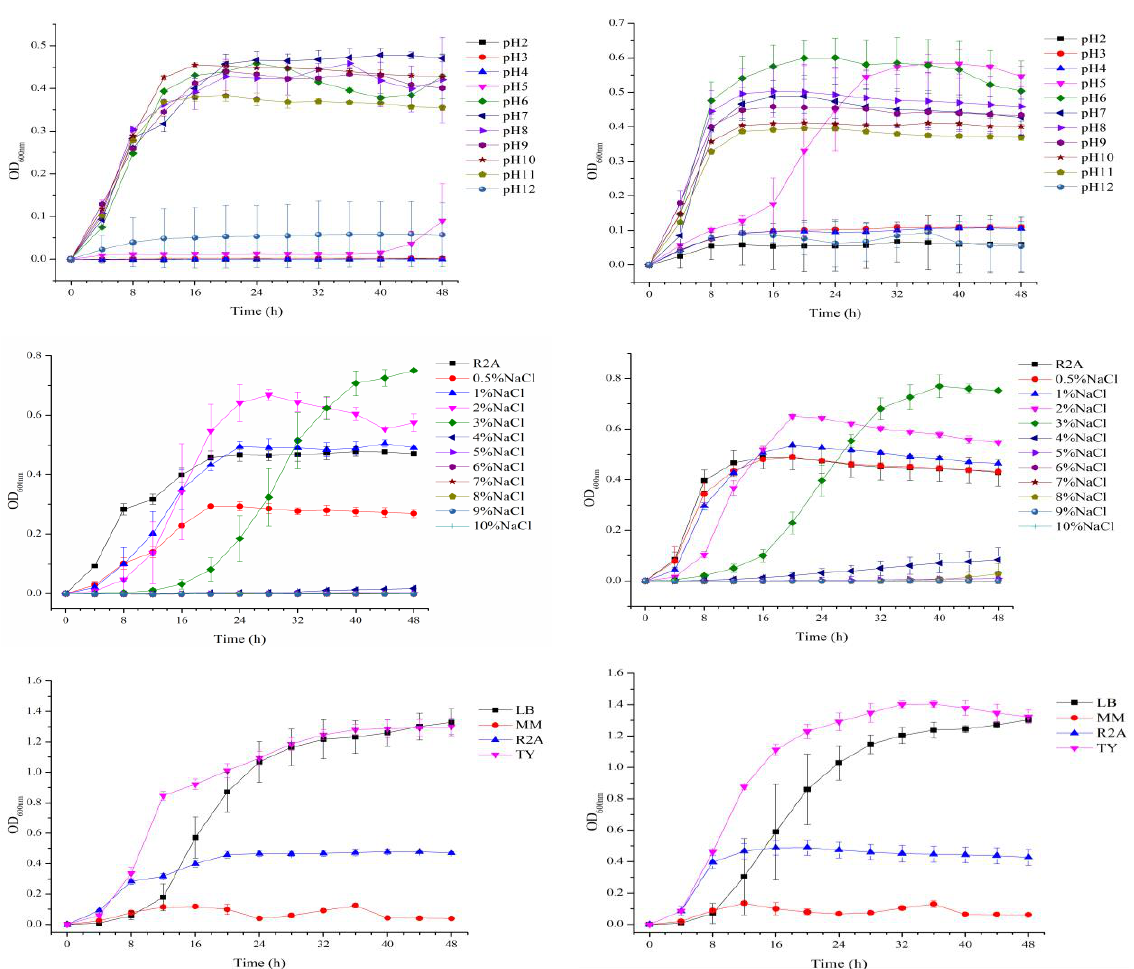
Figure 1. Optimized growth patterns of B. nasdae strains Au-Bre29 and Au-Bre30. Au-Bre29 and Au-Bre30 were cultured individually in R2A medium with different pH levels (2–12, additional NaCl = 0%), different additional NaCl concentrations (0–10%, pH = 7.0), and different media (MM, R2A, TY and LB, pH = 7.0). Performed in the Bioscreen C microbiology reader at 28 ◦ C for 48 h, and the optical densities at 600nm (OD 600nm ) were automatically measured at 4 h intervals. The growth curves display the results of three replicates, and error bars represent the standard error of the average